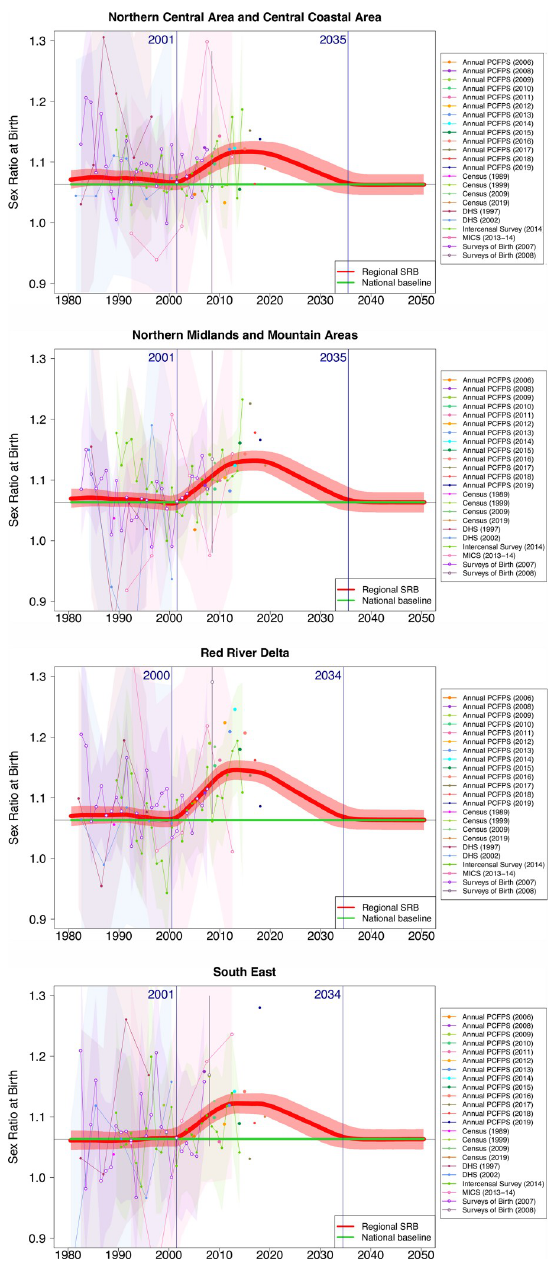
Fig 3. SRB estimates and projections for Vietnamese regions with imbalanced SRB during 1980–2050. The red line and shades are the median and 95% credible intervals of the region-specific SRB, respectively. The green horizontal line refers to the SRB baseline for Vietnam as a whole at 1.063 [2]. SRB observations are displayed with dots, and observations are connected with lines when obtained from the same source. Shaded areas around observation series represent the sampling variability in the series (quantified by two times the sampling standard errors). The start and end years of the sex ratio transition are shown by blue vertical lines.